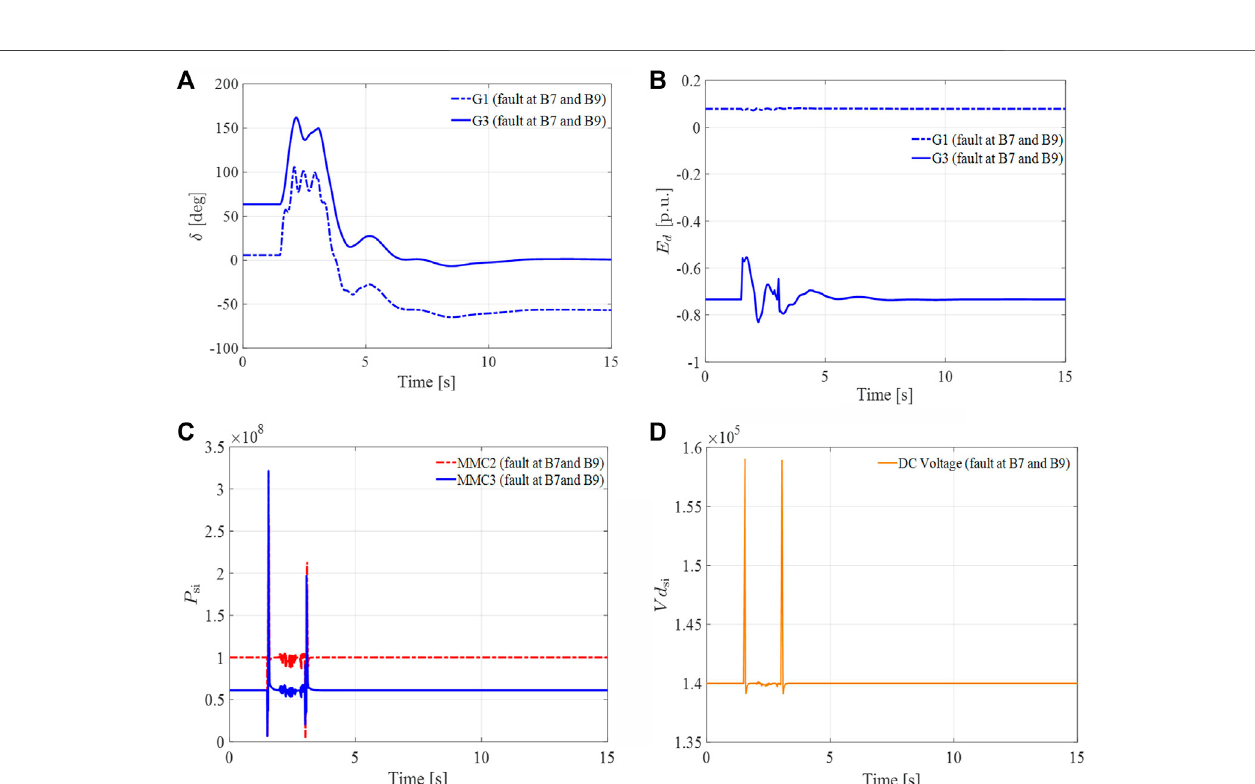
FIGURE 11 | Dynamic responses of the generator and the MMC – MTDC. (A) The rotor angle of generator 3 in degrees. (B) d-axis component of the voltage 3 behind transient reactance in p.u. (C) Active power of MMC2. (D) DC Voltage of MTDC system.